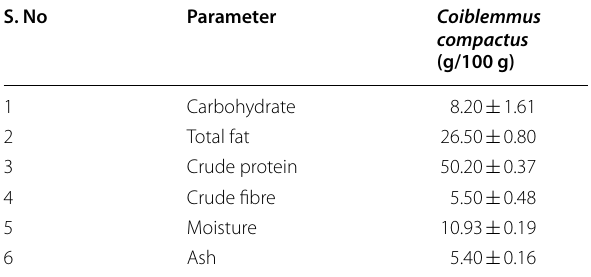
Table 2 Proximate compositions of Coiblemmus compactus